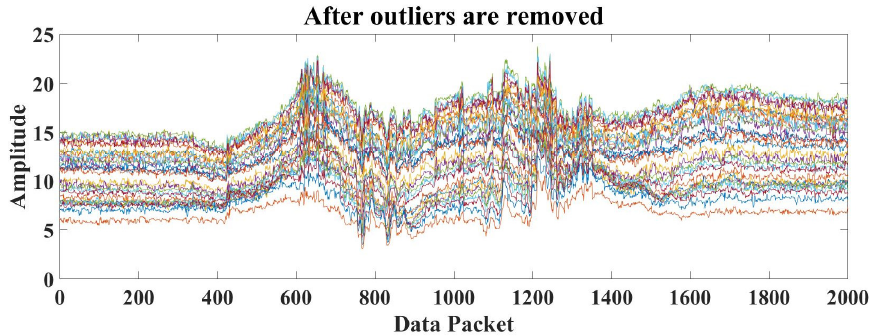
Figure 4. Data packet after outlier algorithm processing.